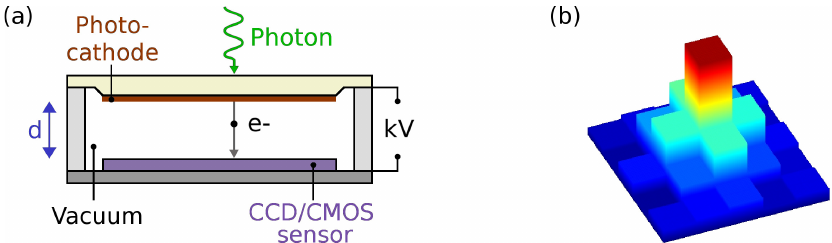
Figure 1. ( a ) Schematic diagram of an electron bombarded sensor. A photon impinging on the photocathode liberates a photoelectron, e − . Using a large potential difference of several kV, the photoelectron is accelerated over a distance d into the sensor, where it creates electron-hole pairs; in silicon, one electron-hole pair for each 3.7 eV depending on conditions such as temperature and impurities; ( b ) Schematic of typical photon event charge distribution in the sensor. The event covers several pixels, with a high central peak and small